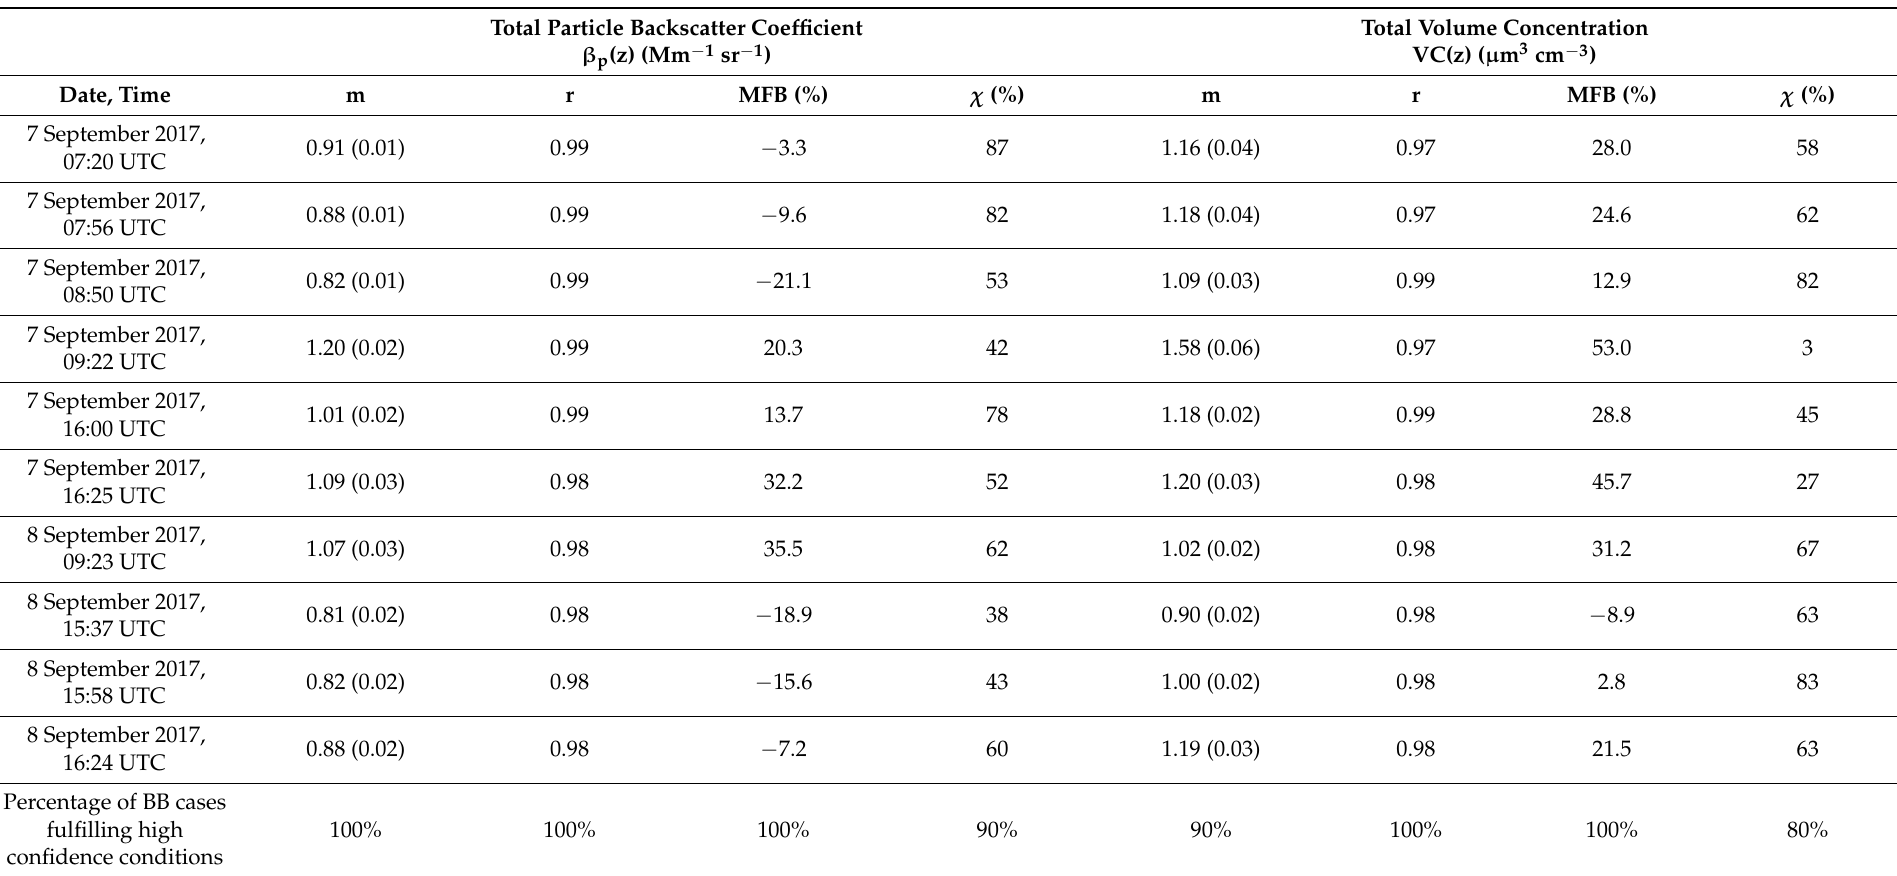
Table 4. GRASP vs. lidar-derived retrieval of the total particle backscatter coefficient ( β p (z), Mm − 1 sr − 1 ) and total volume concentration (VC(z), µ m 3 cm − 3 ). Results obtained from the linear regression, i.e., m (and their error in brackets) and r, together with both MFB and χ values for those 10 selected BB cases. The profiles are averaged at the time interval of ± 15 min around the sun photometer